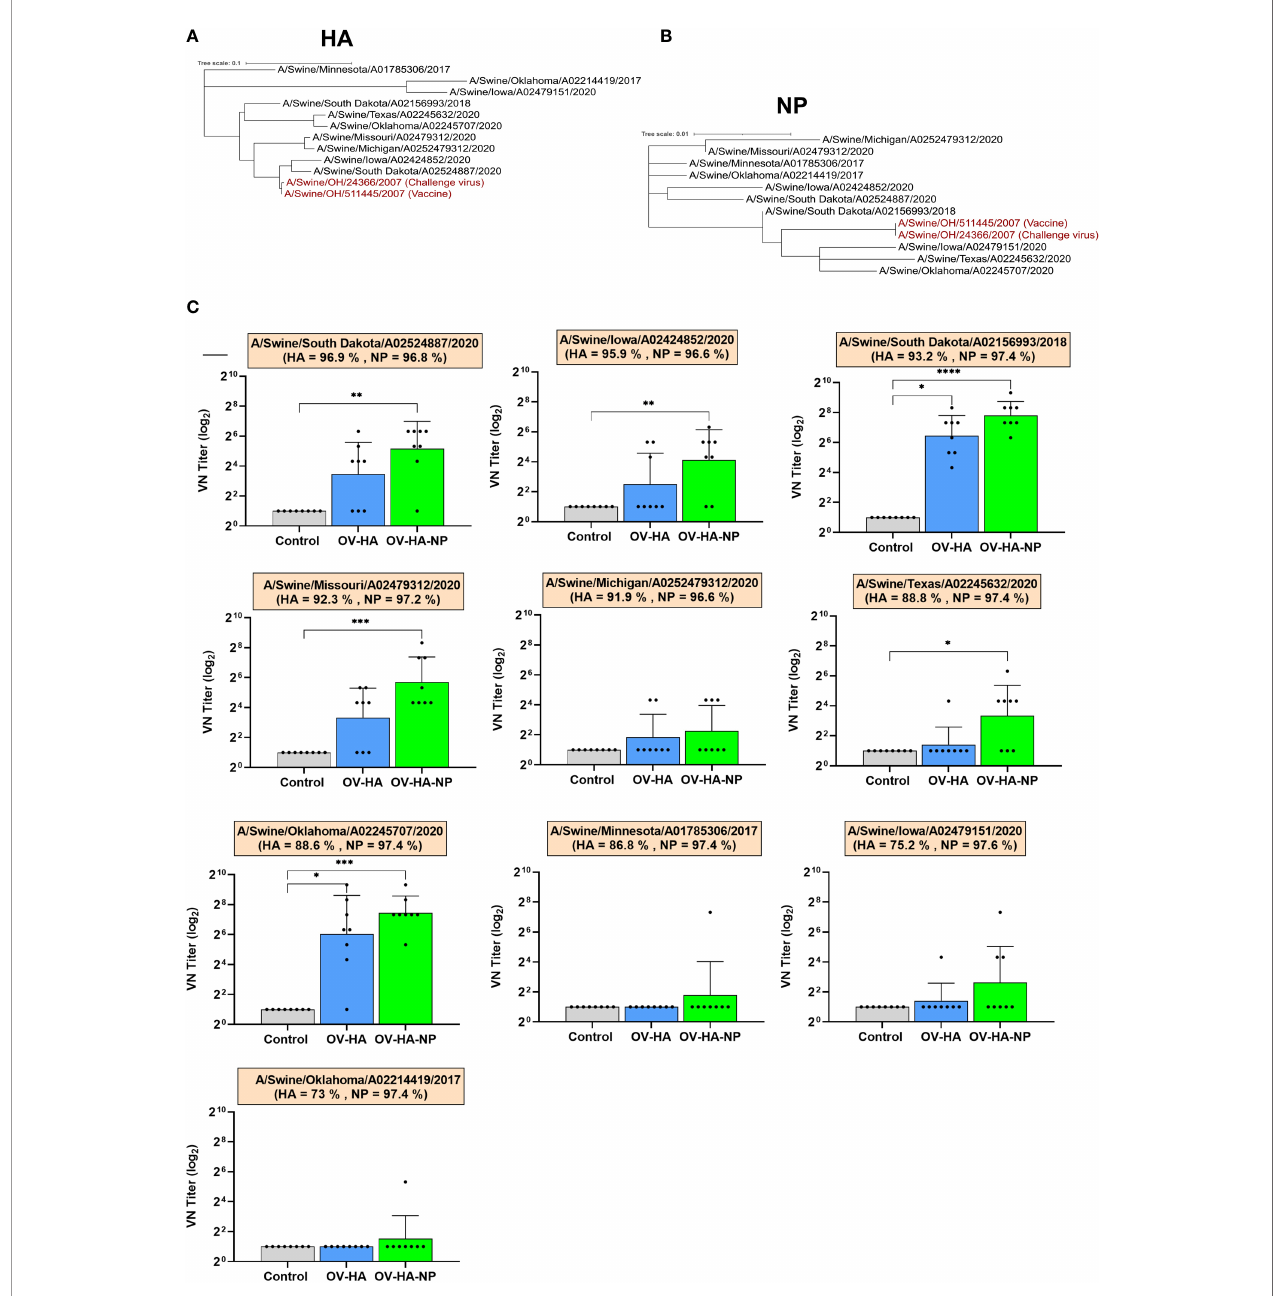
FIGURE 7 | Cross-neutralization assay. (A) Phylogenetictree based onHA amino acid sequence. Animoacid sequences were aligned usingMUSCLE and trees were constructed using Maximum Likelihoodmethodimplemented inMEGA-X(53). (B) Phylogenetictree based on aminoacid sequence of NP protein. Sequences were aligned usingMUSCLE and trees were constructed using Maximum Likelihoodmethod. (C) Cross-neutralizingantibody titersagainst different IAV-S viruses in theserum samples collected on 35 days post-immunization.Each panel represents one virus isolateand the percentage ofits HA/NP similarity with that ofvaccine HA/NP isprovided under the name of each isolate. Bar represent mean and error bar represent SEM. P-values: *P < 0.05, **P < 0.01, ***P < 0.001, ****P <